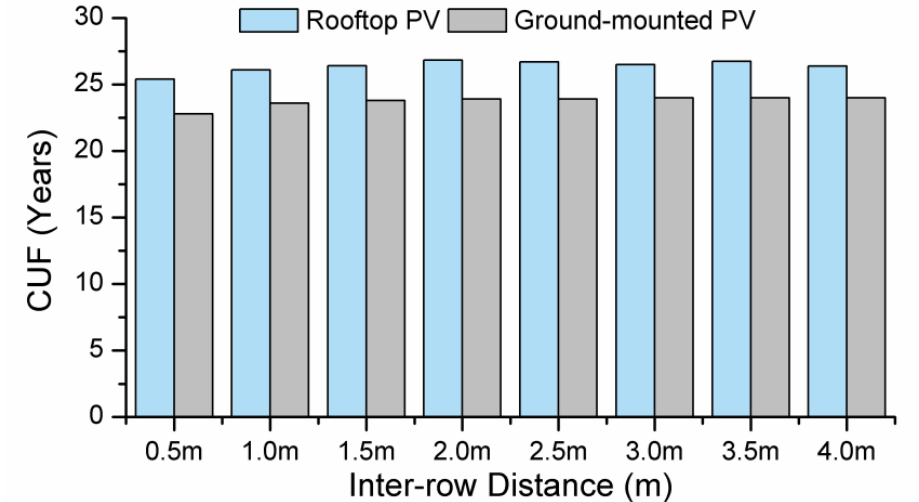
Figure 13. Capacity utilization factor (CUF) of the ground-mounted and rooftop PV systems.